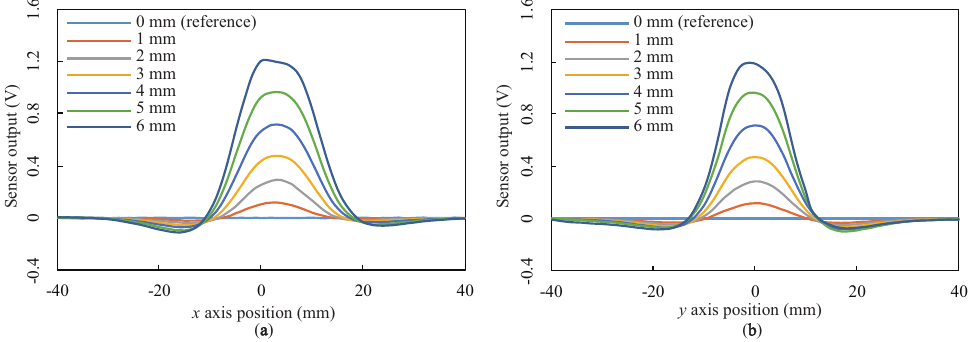
Figure 10. Line profiles of the measured spatial responses with at seven different depths: ( a , b ) Sensor outputs along the x and y axes through the point ( x o , y o ) = (3, 0),